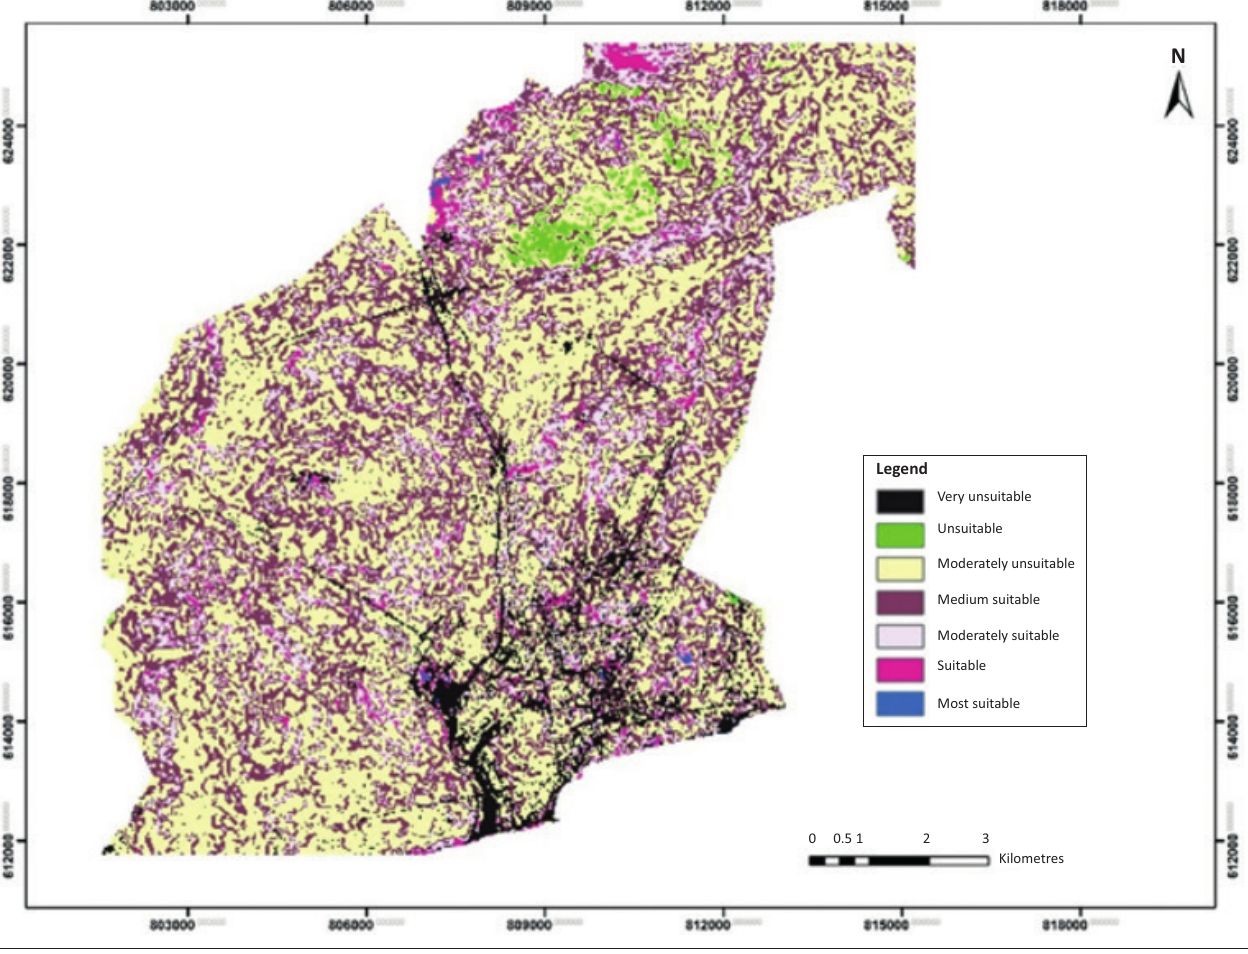
FIGURE 7: Suitability of sites for flood emergency evacuation centres in Accra in the metropolitan